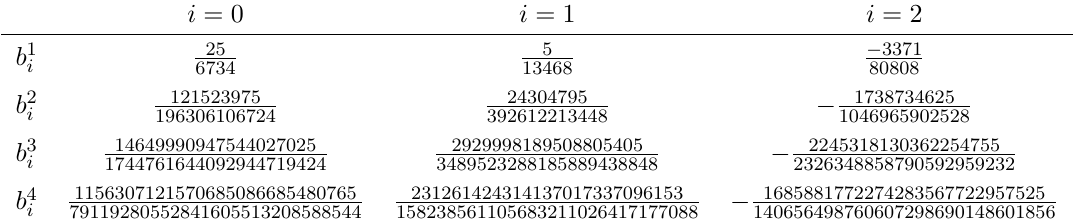
Table 2 . The first few b n